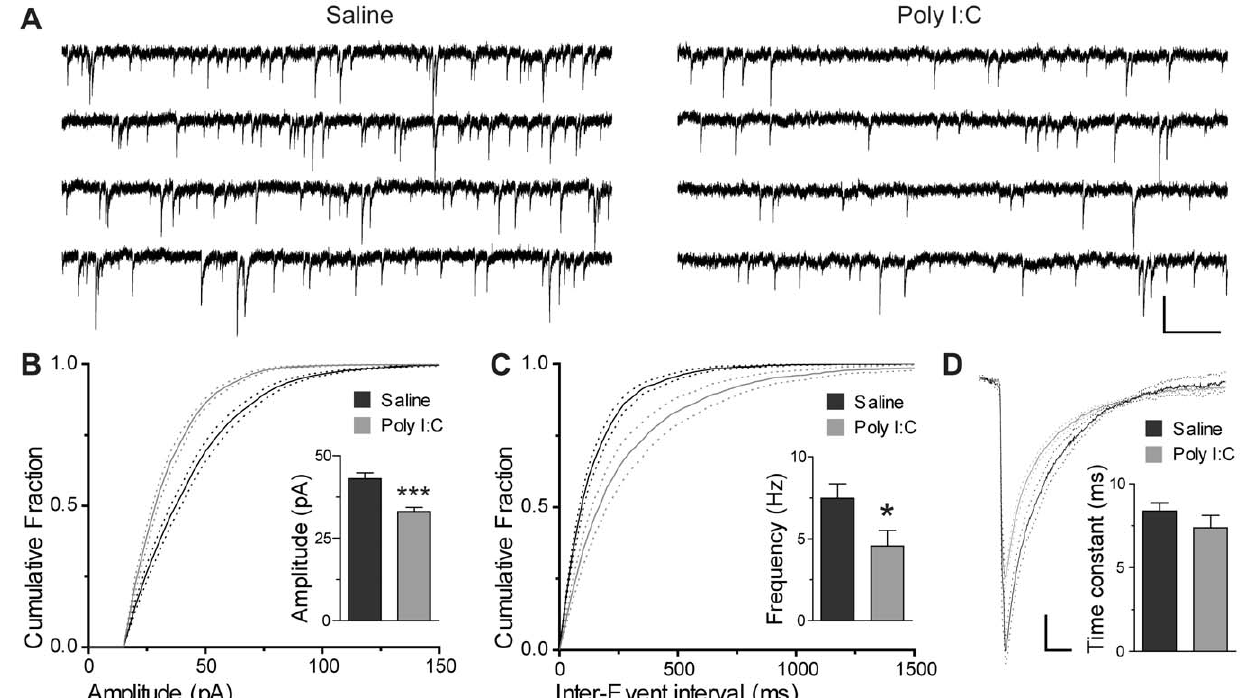
Figure 2. Prenatal immune challenge decreases the frequency and amplitude of miniIPSCs recorded in CA1 pyramidal cells. A ) Representative miniIPSC recordings from animals prenatally exposed to saline (left) or poly I:C (right). Scale bar 500 ms (horizontal) and 60 pA (vertical). B ) Average cumulative amplitude histogram ( 6 SEM) of miniIPSCs recorded from the saline and poly I:C group. Inset: average mean IPSC amplitude (100 events averaged for each cell) recorded for each group. C ) Average cumulative inter-event interval histogram ( 6 SEM) of miniIPSCs recorded from saline and poly I:C treated animals. Inset: average frequency of miniIPSCs of all cells recorded for each group. D ) Average waveform of 100 mini events from each cell for both groups ( 6 SEM), scale 5 pA (vertical) and 5 ms (horizontal). Inset: Average miniIPSCs time constant. n=7 for both groups.